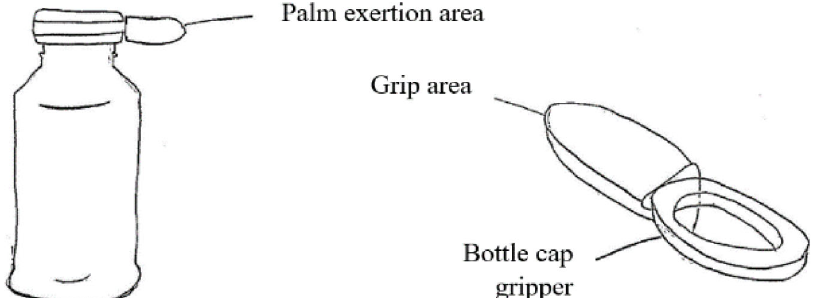
Figure 9. Partial action concept design.